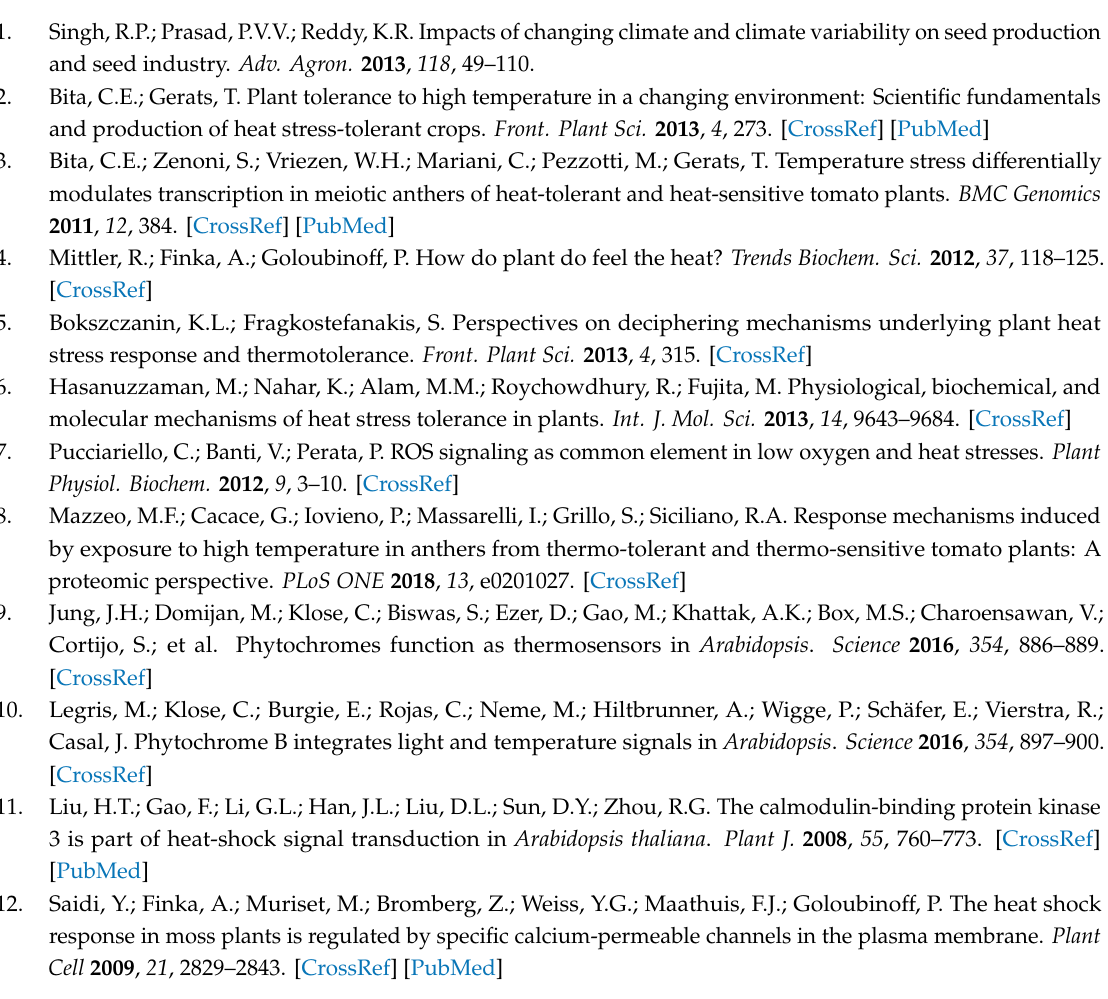
BN1. Figure S2. Primer sets used to amplify DNA from BN1 and BN2. Figure S3. Comparison of BoTPPI-2_BN1 and BoTPPI-2_BN2 sequences after removal of the LTR sequence from BoTPPI-2_BN2 . Figure S4. Phylogenetic analysis of BoTPPI genes on the basis of the coding sequence (CDS). Figure S5. Marker validation using diverse B. oleracea genotypes. Figure S6. Marker validation using cabbage samples provided by Asia Seed Co. Figure S7. Marker validation using Japanese cultivars supplied by the Golden Seed Project (GSP) Center. Figure S8. Marker validation using cabbage genotypes obtained from various sources. Table S1. B. oleracea samples used in marker development and validation for hot tolerance and susceptible. R, heat-resistant, S, heat-susceptible. Table S2. List of primers used in gene cloning and marker development. Table S3. List of primers used in RT-PCR analysis. Table S4. Summary of RNA sequencing and assembly. Table S5. Summary of RNA-seq data expressed as reads per kilobase of transcript per million mapped read